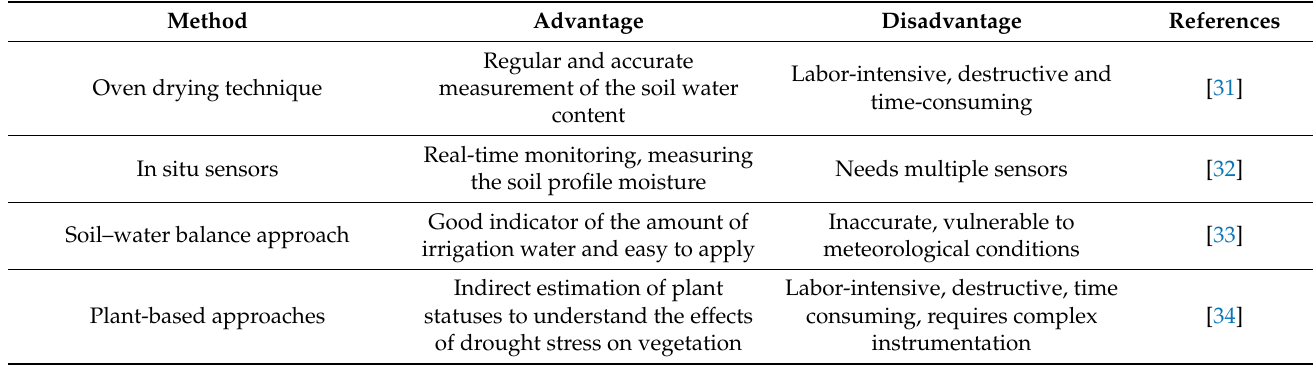
Table 1. Summary of the soil moisture content